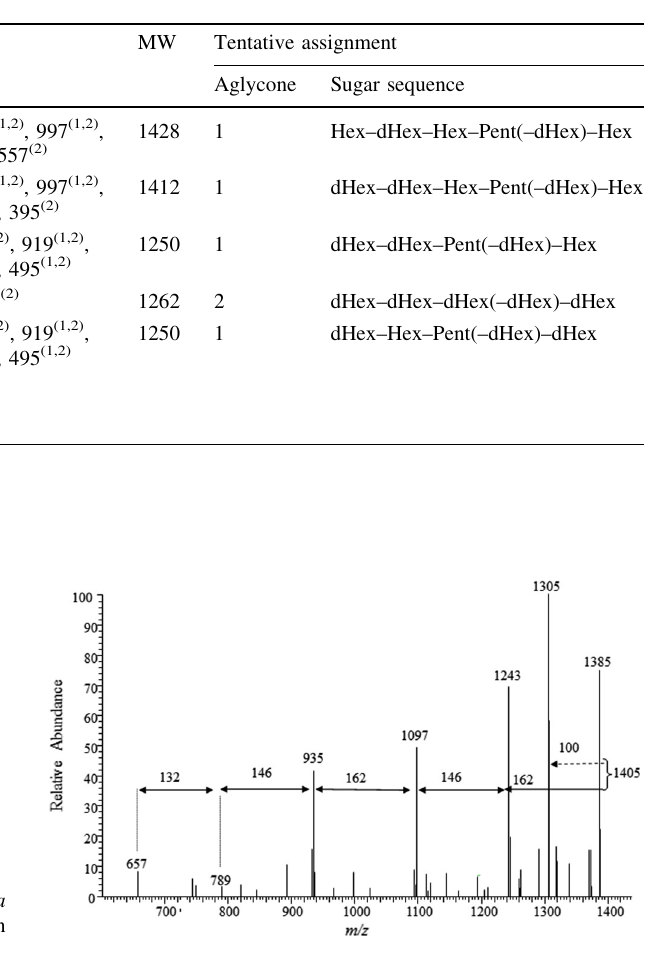
Fig. 4 Mass spectrum obtained after UPLC-ESI-IT-MS n experiment using the precursor